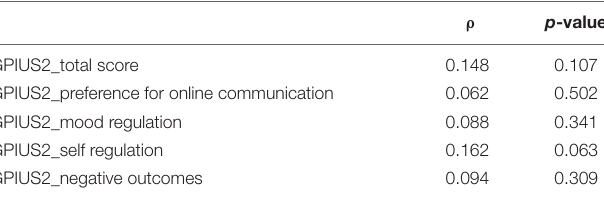
TABLE 2 | Correlations between BDI-II and GPIUS2 scores.